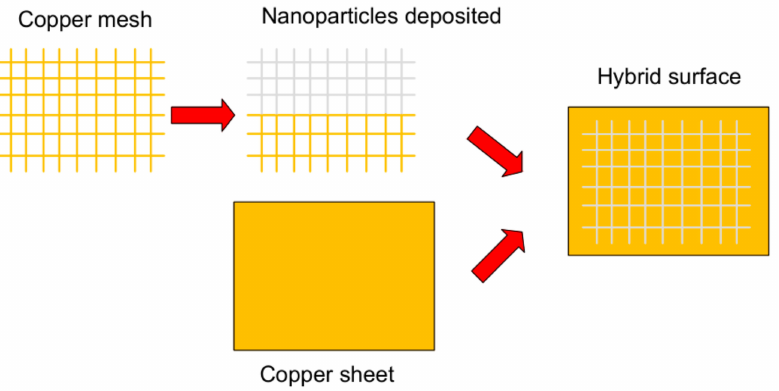
Figure 11. The preparation procedure for the hybrid superhydrophobic-hydrophilic surfaces [78]. Cao et al. [79] prepared a hydrophobic/hydrophilic cooperative Janus system (Figure 12), which could reduce the re-evaporation rate of harvested water molecules, and a thinner collection surface boundary layer helps improve absorption efficiency.